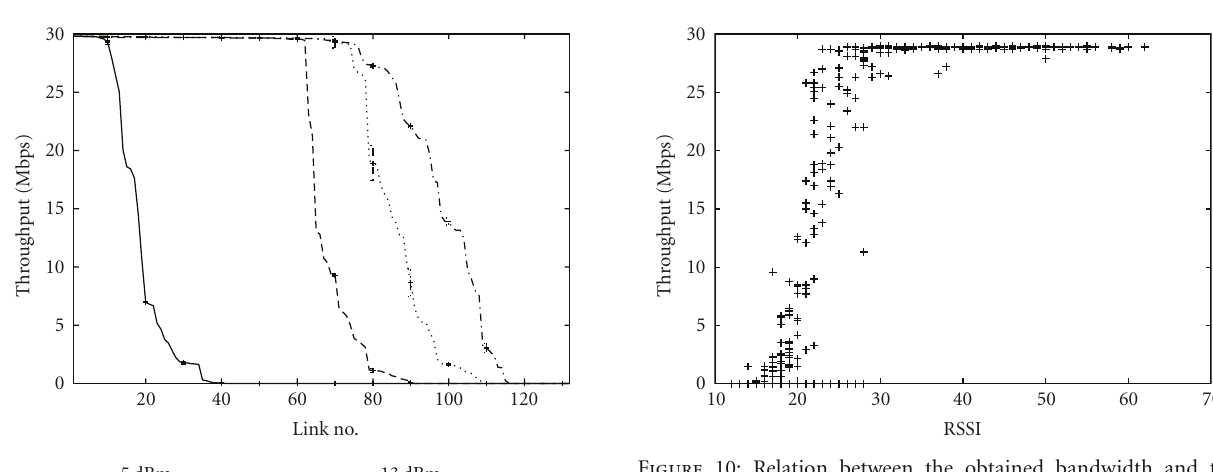
Figure 10: Relation between the obtained bandwidth and the reported RSSI by the 802.11a